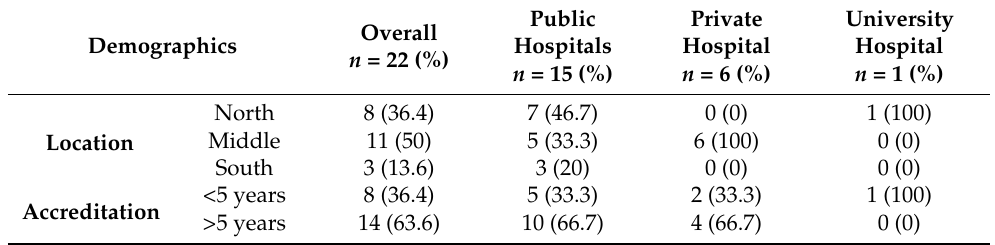
Table 1. Participating hospitals’